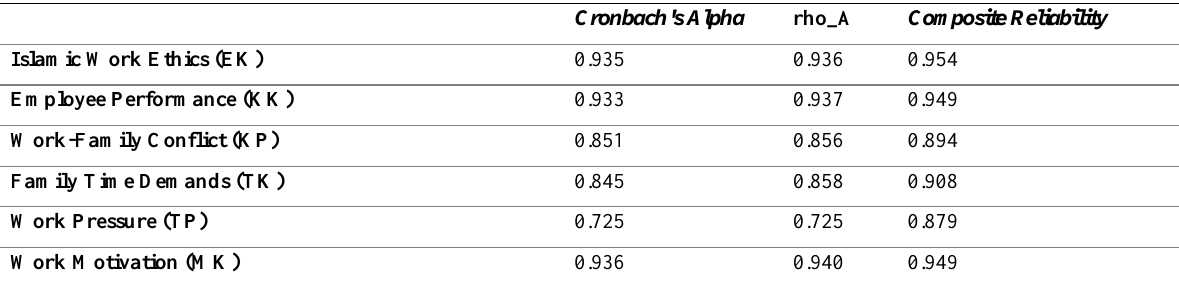
Table 4: Composite Reliability and Cronbach’s